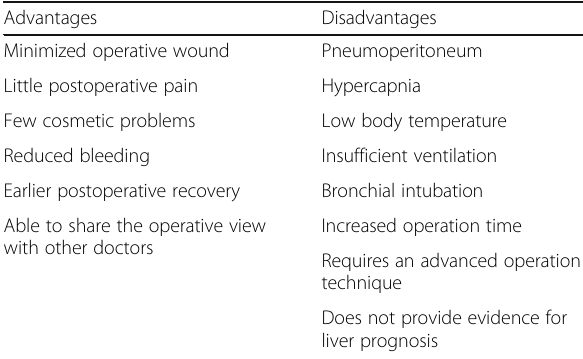
Table 4 Advantages and disadvantages of laparoscopic Kasai